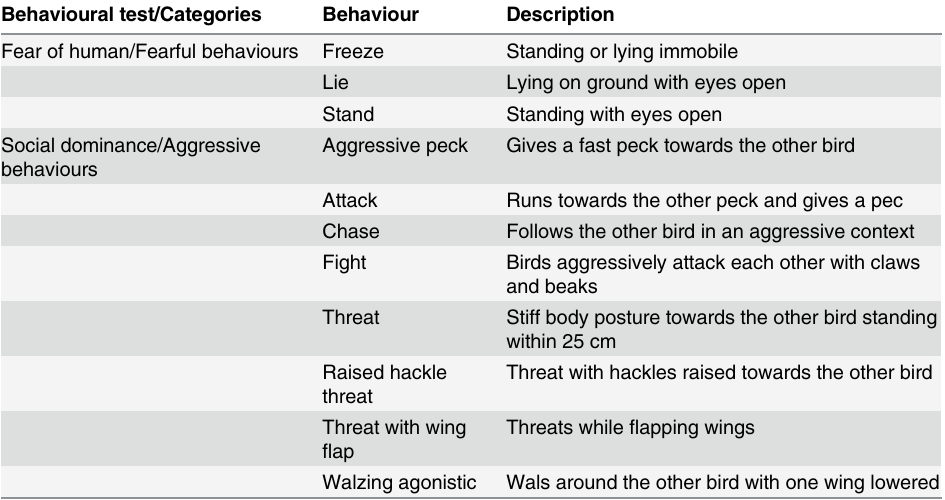
Table 1. Behaviours recorded in the fear of human and social dominance